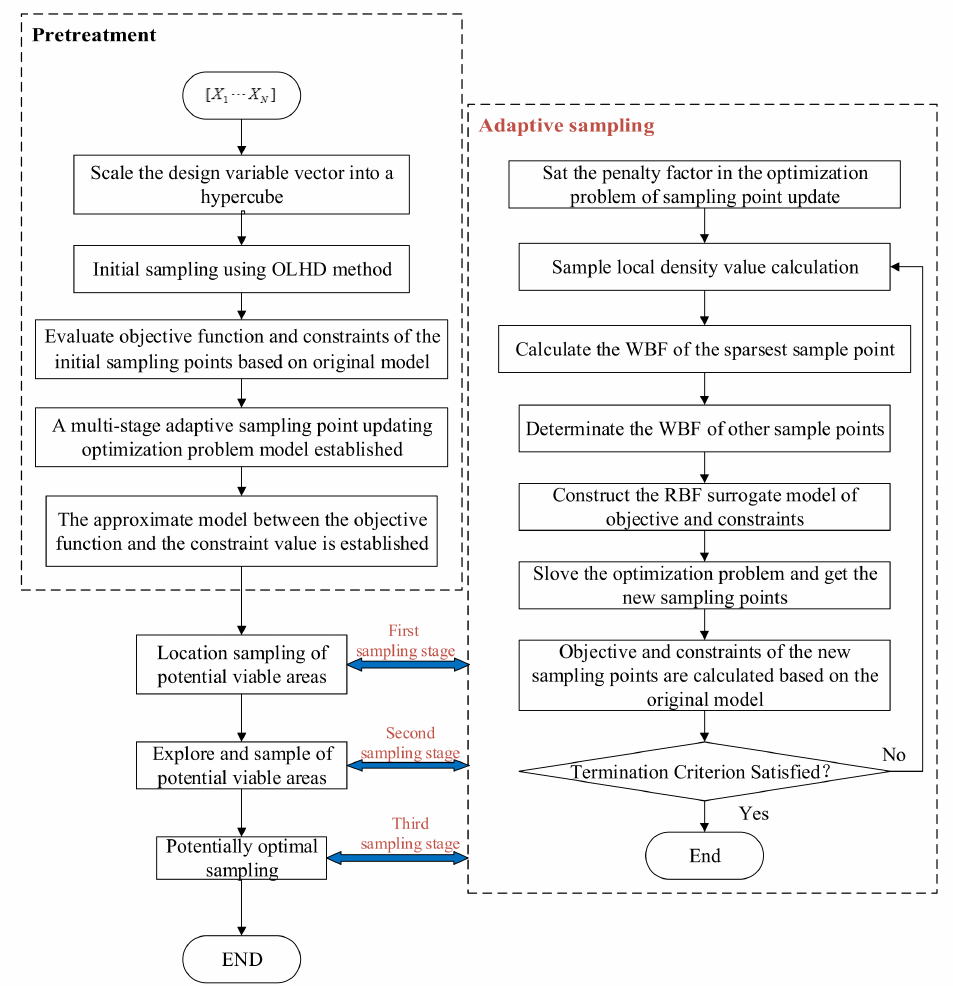
Figure 1. Flow Chart of Improved surrogate-based optimization